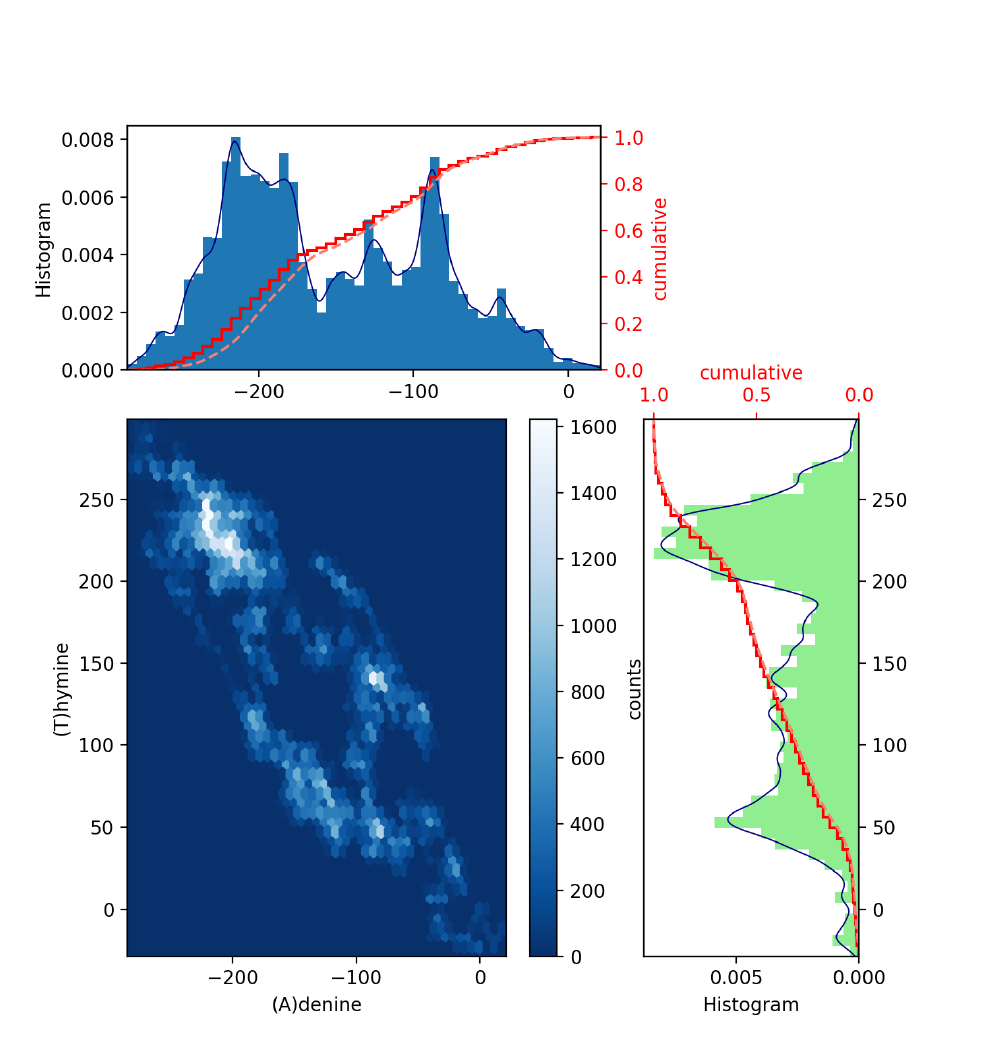
Figure 2. Scatter plot of GenomeBits (A)denine and (T)hymine curves with histograms for the monkeypox virus (GenBank ID